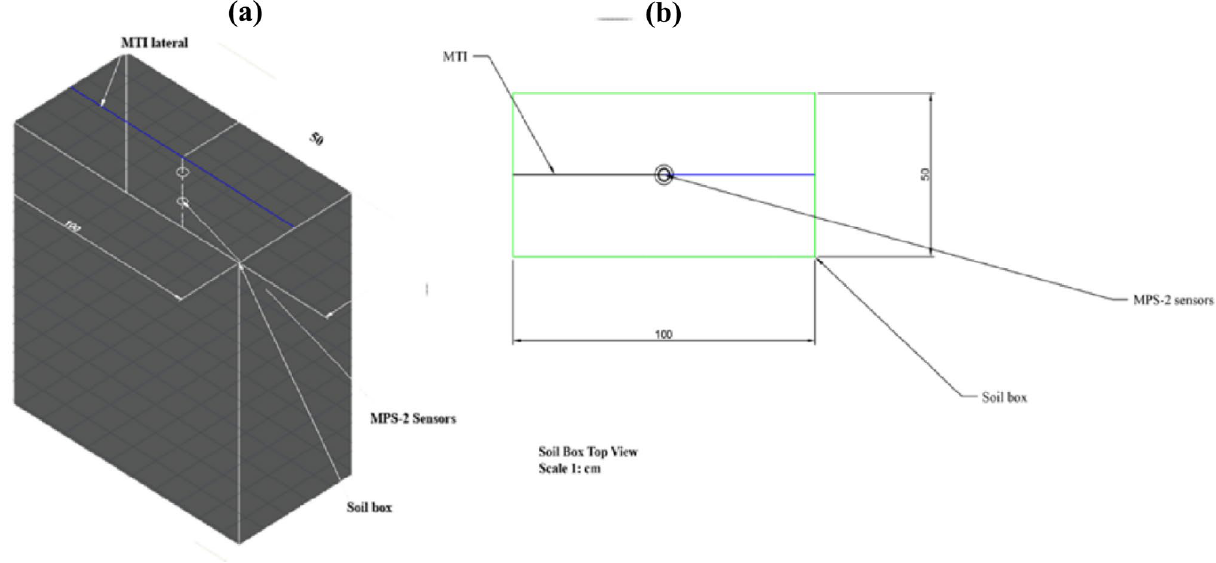
Figure 1. Soil bin experimental set-up ( a ) 3-D view and ( b ) orthographic top view. Dimensions in